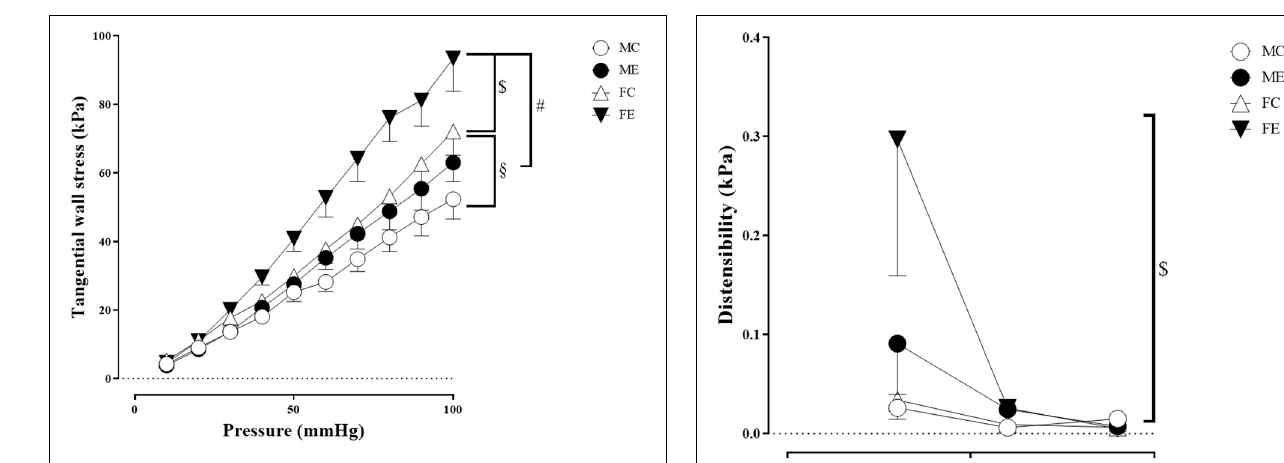
FIGURE 2 | Tangential wall stress as a function of intraluminal pressure measured in passive conditions of the gracilis muscle arterioles from the MC, ME, FC, and FE animals. The tangential wall stress was significantly increased in the FE rats compared with the controls. In addition, this value was significantly higher in the FC and FE rats than in the MC and ME rats. The data are expressed as the mean (SEM) values. The significance levels of two-way ANOVA and Tukey’s post hoc tests between the four groups are shown. $ P < 0.05 FC vs. FE; § P < 0.05 MC vs. FC and # P < 0.05 ME vs. FE.